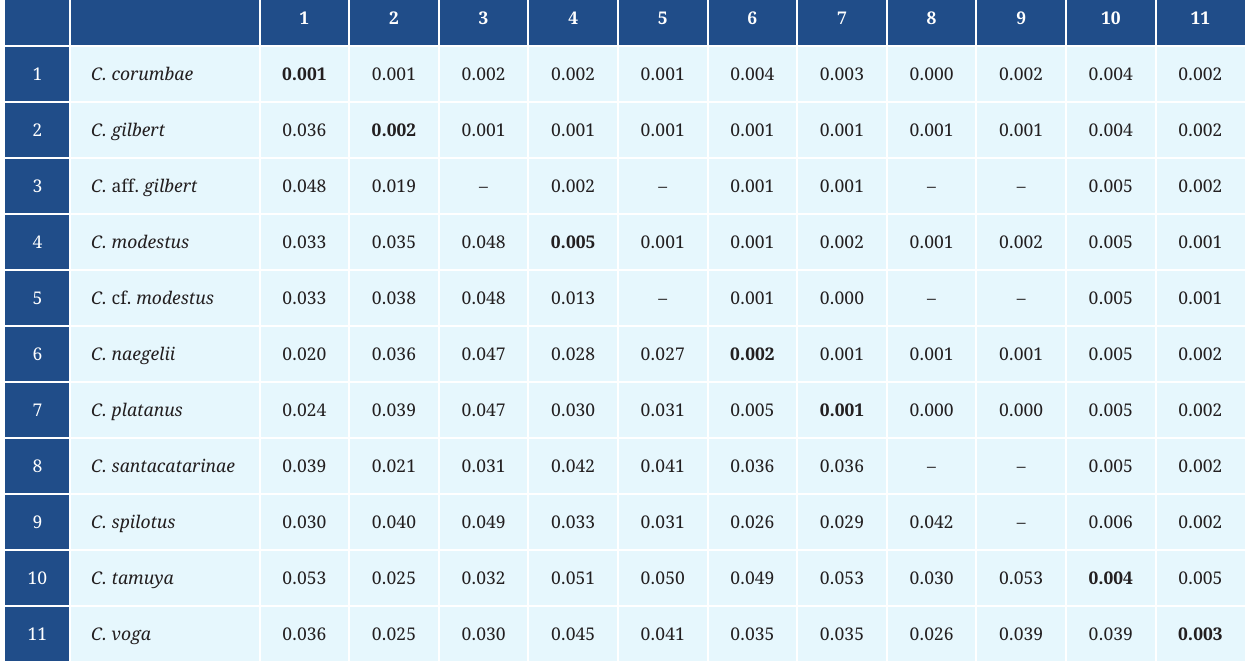
TABLE 3 | Average barcoding divergence (%) among species of the Cyphocharax gilbert clade based on the Kimura two-parameters model using COI data matrix. Values in bold refer to intraspecific distance within each species. Values above the diagonal refer to standard